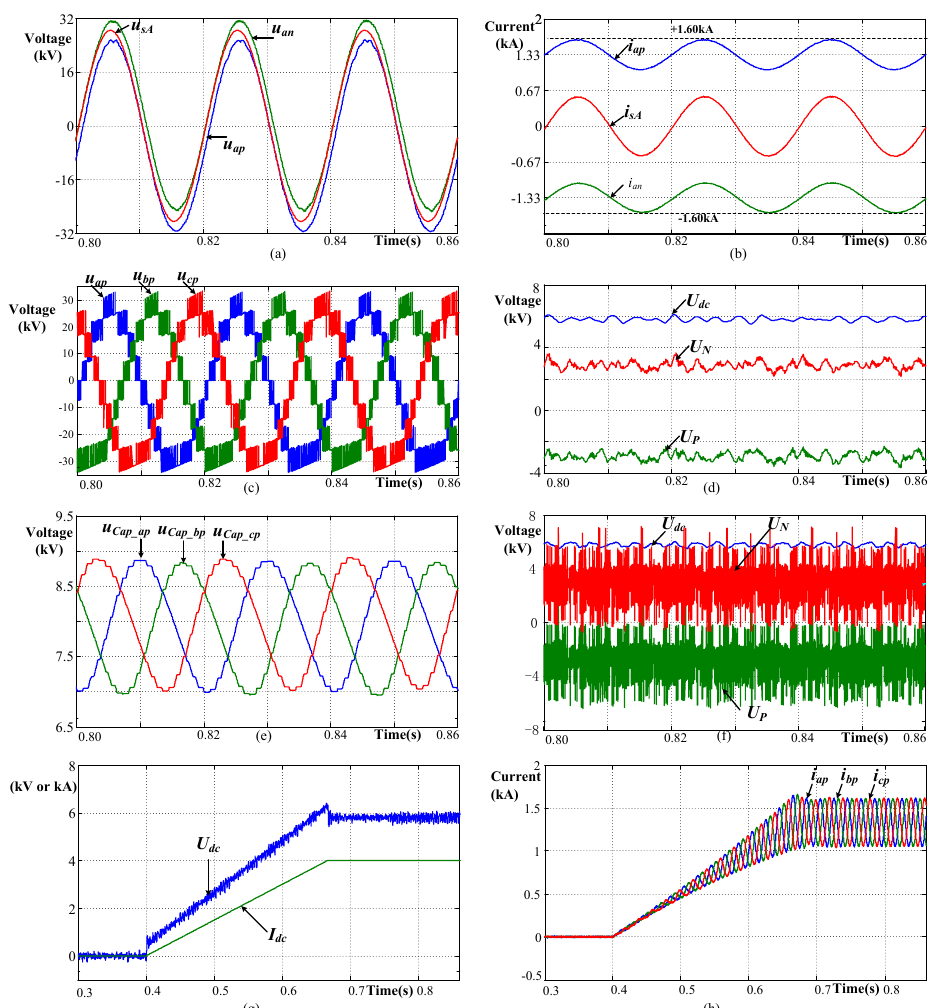
Figure 6. Simulation results of the conventional MMC-DDI. ( a ) arm voltage (fileted high-frequency ripple), ( b ) arm current, ( c ) arm voltage (unfiltered), ( d ) DC-side voltage (fileted high frequency ripple), ( e ) submodule capacitor voltage, ( f ) DC-side voltage (unfiltered), ( g ) DC-side output voltage and current during melting-ice startup process, ( h ) arm current during melting-ice startup